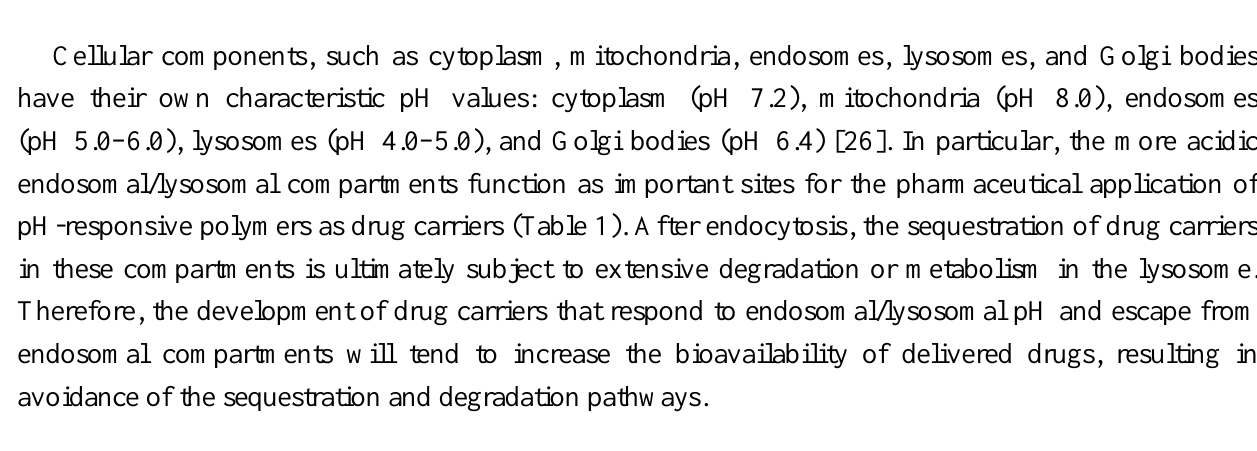
Table 1. Examples of pH-responsive